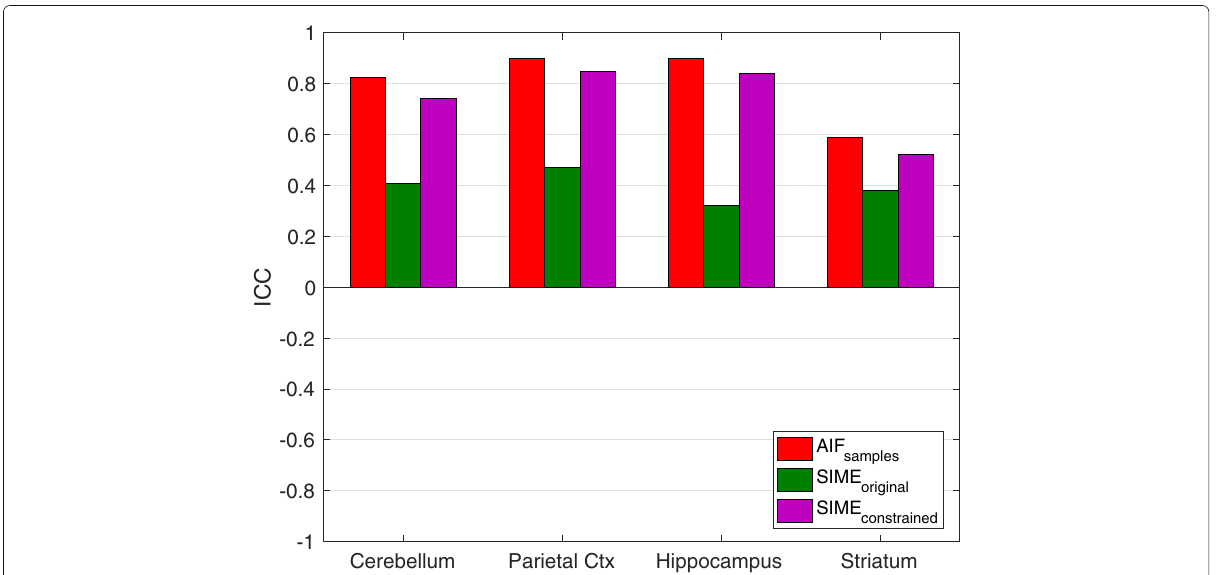
Fig. 9 Intraclass correlation coefficient (ICC) scores of the V T estimates obtained using AIF samples , SIME original and SIME constrained . +1 represents maximum reliability whereas − 1 represents minimum reliability